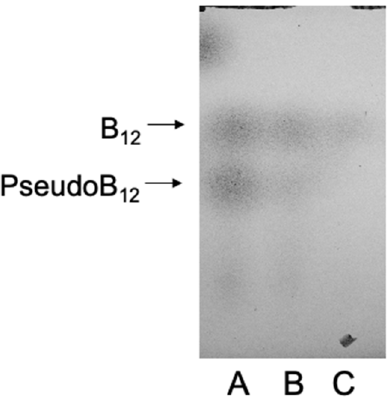
Figure 1. Bioautogram analysis of B 12 compounds detected in selected fermented poultry manure fertilizer products. A, B, and C represent the products listed in Table 1. Typical bioautogram data are obtained from three independent experiments.